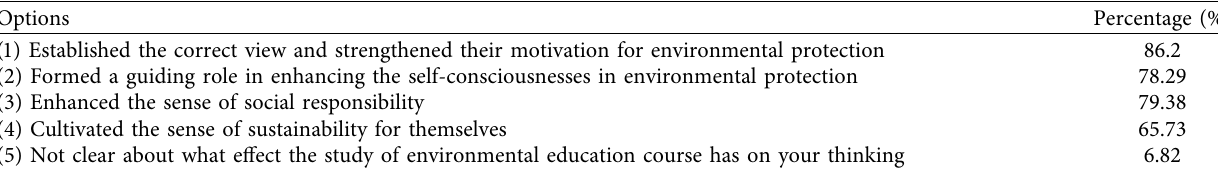
Table 6: College students’ sense of emotion acquisition.